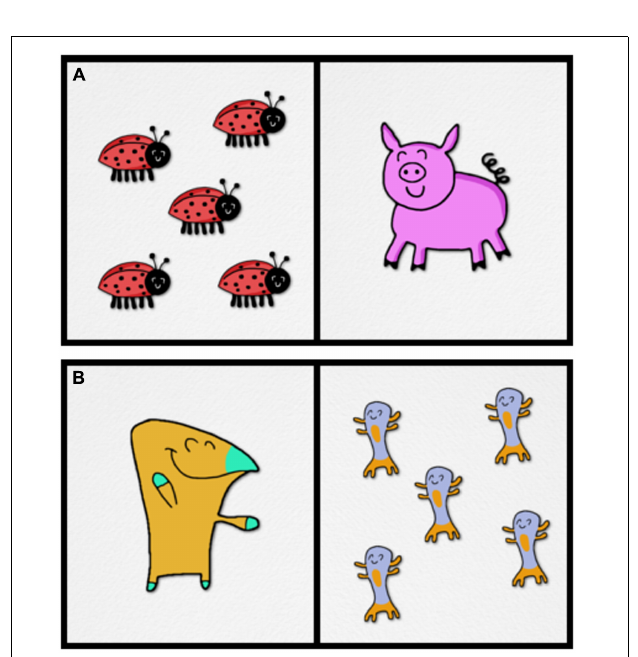
FIGURE 4 | Examples of (A) Known animals and (B) Novel animals.